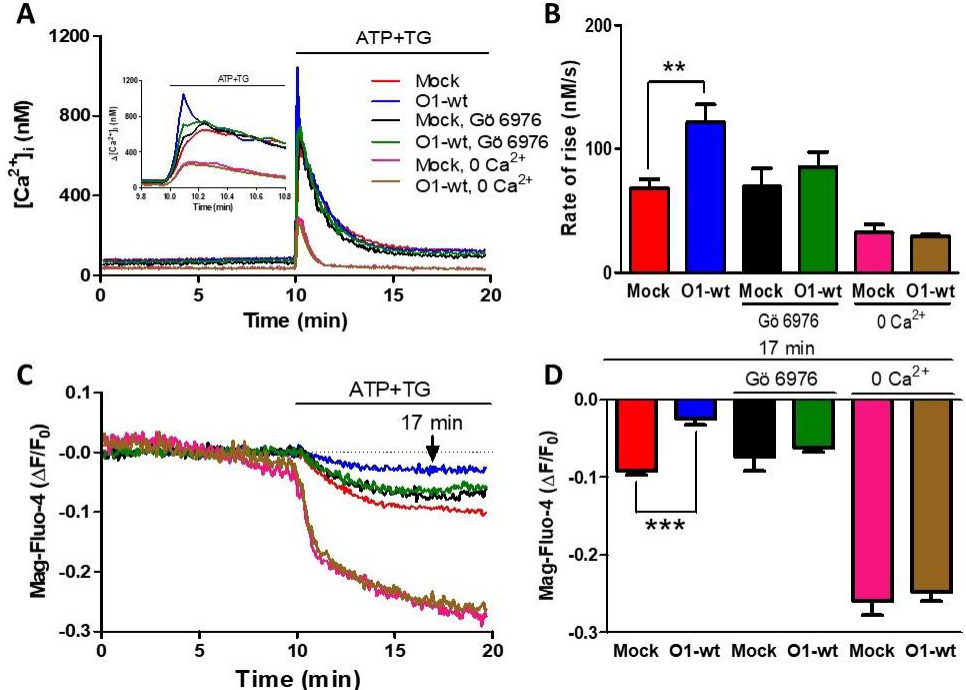
Figure 2. The inhibition of ER Ca 2+ depletion by the Orai1 channel requires PKC activation and the presence of external [Ca 2+ ]. ( A ) Time course of the [Ca 2+ ] i response to the addition of ATP-TG for either untreated mock cells (red trace) or mock cells in the presence of 200 nM Gö 6976 (black trace) or the absence of external Ca 2+ (pink trace). The same conditions were applied to cells overexpress- ing the O1-wt channel: no treatment (blue trace); 200 nM Gö 6976 (green trace) or in the absence of external Ca 2+ (brown trace). The inset shows the time course of the initial increase in the [Ca 2+ ] i trig- gered by the addition of ATP and TG. ( B ) Bar graphs show the average initial rate of [Ca 2+ ] i rise for those conditions displayed in panel A. Data are the mean ± SEM. The student’s t-test for one tail was used to compare each treatment with its corresponding mock. Both conditions inhibited the increase in the rate of [Ca 2+ ] i rise seen with O1-wt. ( C ) The time course of the reduction in the [Ca 2+ ] ER induced by ATP and TG for those cells depicted in panel A. ( D ) Bar graphs showing the Mag-fluo-4 fluores- cence at 7 min after the addition of ATP-TG. ** p < 0.01; *** p < 0.001. The number of independent experiments was n = 10 for mock cells and 5 for the rest. Bars represent the mean ± SEM. 2.3. The Mutant Orai1 S27/30A Channel (O1-AA) Did Not Inhibit ER Ca 2+ Release, While the Phosphomimetic S27/30D Channel (O1-DD) Inhibited ER Ca 2+ Release without Any Participation of PKC As PKC phosphorylates Orai1 on Ser27 and Ser30 amino acid residues, we decided to study whether this process is involved in reducing Ca 2+ release and the higher Ca 2+ tran- sient by overexpressing O1-wt. The overexpression of the mutant O1-AA showed a simi- larly increased rate of [Ca 2+ ] i rise as for the O1-wt (Figure 3A,B, black traces and bars). This effect required a functional channel as the dominant-negative mutant O1-AA-E106A in- creased neither the peak nor the rate of [Ca 2+ ] i rise in response to ATP and TG (Figure S3). Moreover, the effect of O1-wt on the [Ca 2+ ] ER response was not present with the O1-AA mutant, as the [Ca 2+ ] ER reduction was similar to the one seen with mock cells (Figure 3C,D, black traces and bars). A completely different situation was observed with the overexpres- sion of the O1-DD channel; both the rate of [Ca 2+ ] i rise, and the [Ca 2+ ] ER response were strongly reduced (Figure 3C,D, green traces and bars). The addition of Gö 6983, a broader PKC inhibitor than Gö 6976 [44], did not restore the inhibited ER Ca 2+ release produced